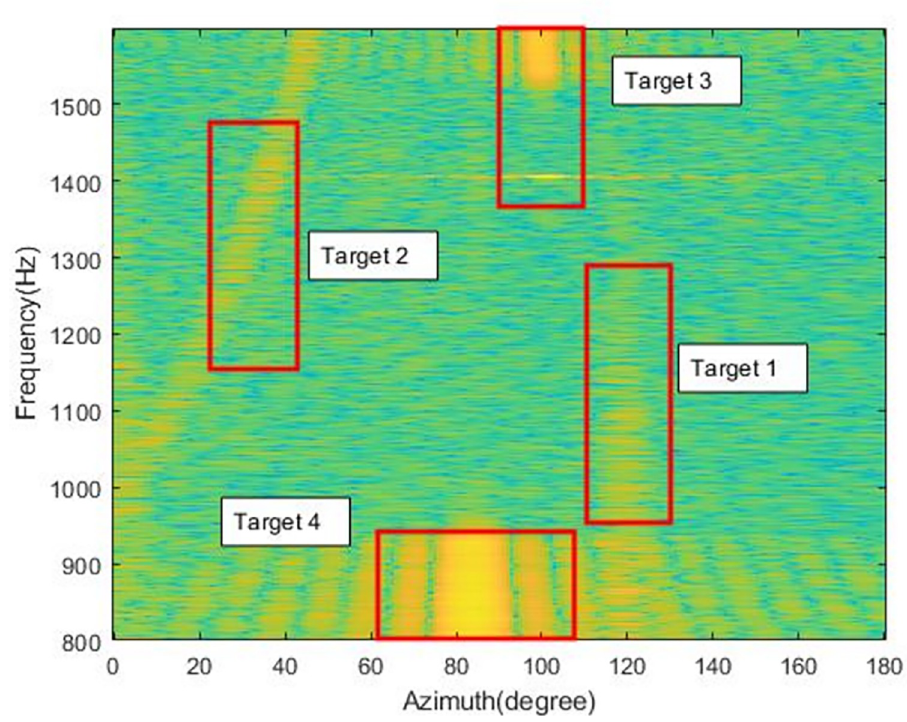
Fig 16. MFSS at time point